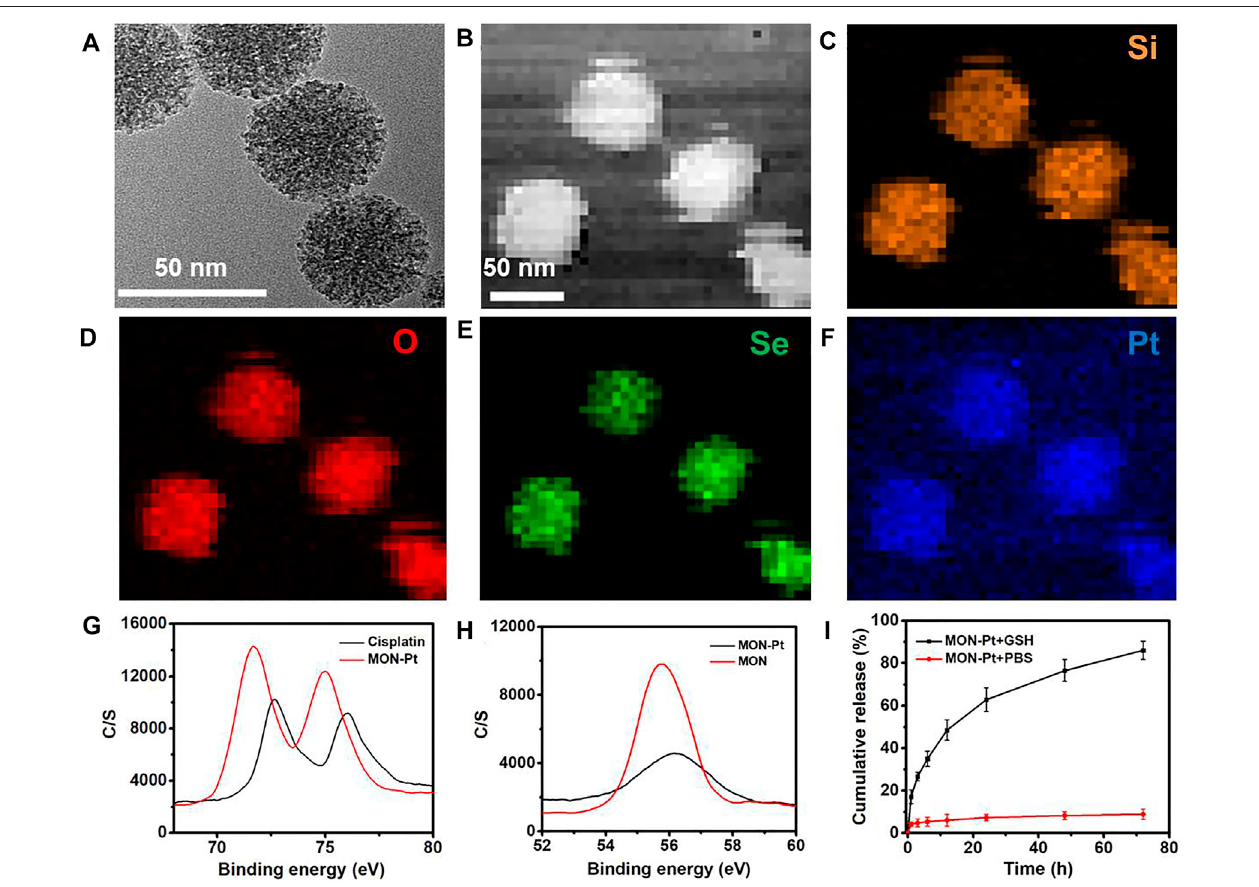
FIGURE2 | Preparation and characterization ofMON-Pt. (A) TEM ofMON-Pt. (B – F) Mapping images of MON-Pt. XPS spectrum of (G) platinum and (H) selenium of MON-Pt. (I) Cisplatin release pro fi les of MON@Pt in the presence or absence of 10 mM GSH. All data are mean ± SD (n = 3).